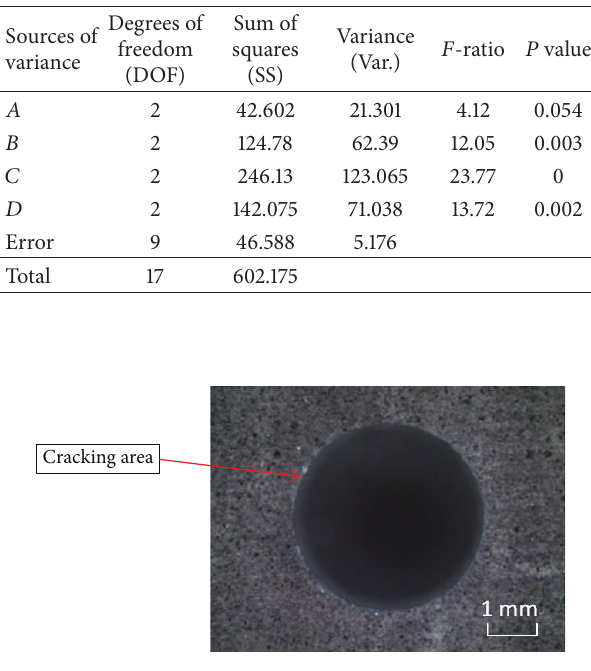
Figure 3: Cracking condition of